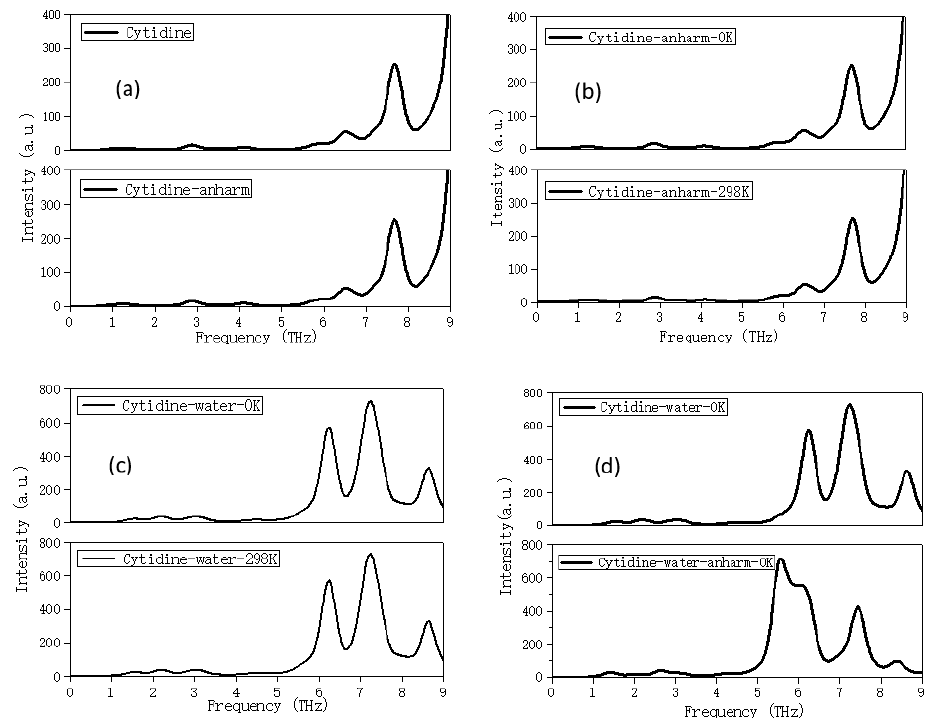
Figure 4. Comparison of the effects of ( a ) different models without solvent, ( b ) different temperatures without solvent, ( c ) different temperatures with solvent, and ( d ) different models with solvent, on the calculation spectra.